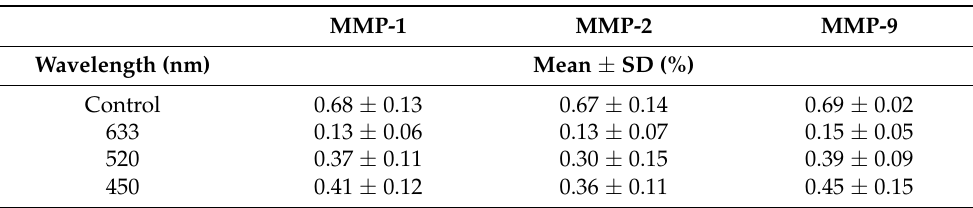
Table 1. Comparison of relative expression of MMP-1, -2, and -9 under illumination at different wavelengths.